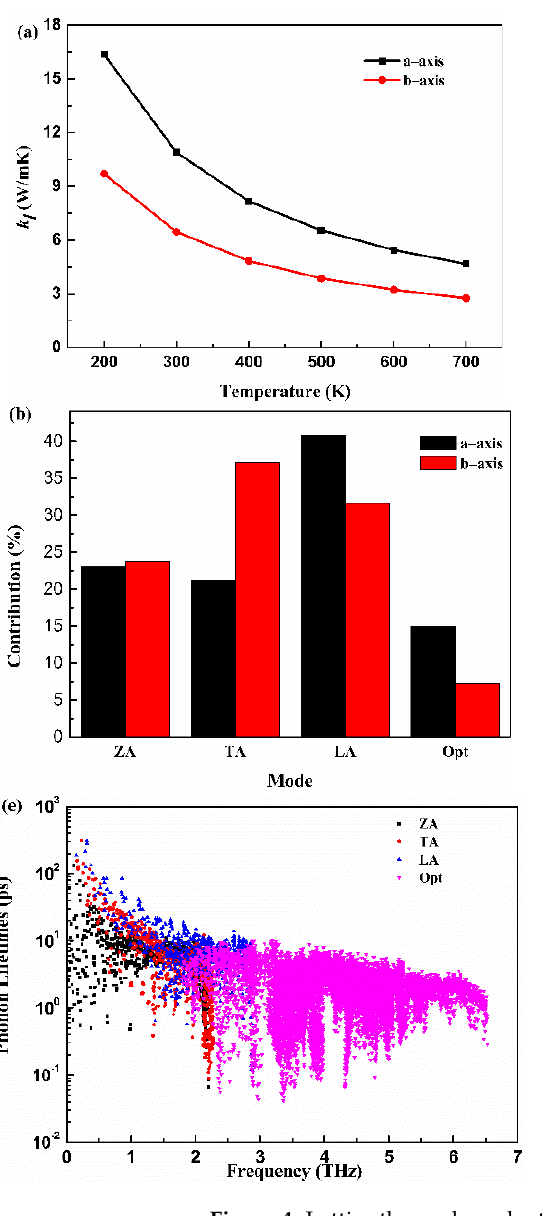
Figure 4. Lattice thermal conductivity ( 𝑘 𝑙 ) as function of temperature ( a ), contributions of phonon modes to lattice thermal conductivity ( b ), frequency-dependence of group velocity along the a-axis and b-axis ( c , d ), phone lifetimes ( e ), mean free path (MFP) ( f ) of the monolayer Hf 2 Br 4 .